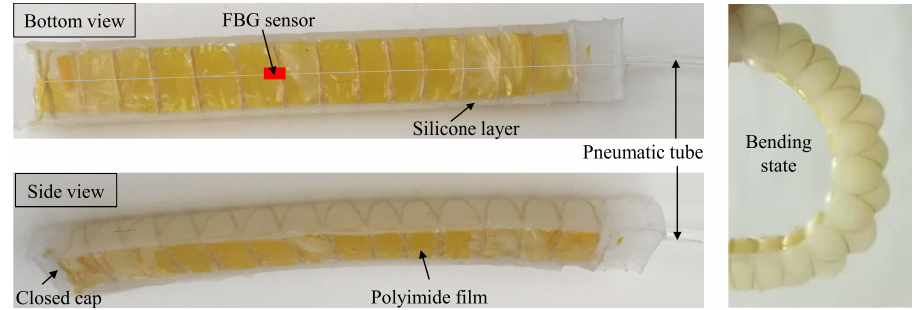
Figure 8. Polyimide FBG sensor application in a soft actuator.